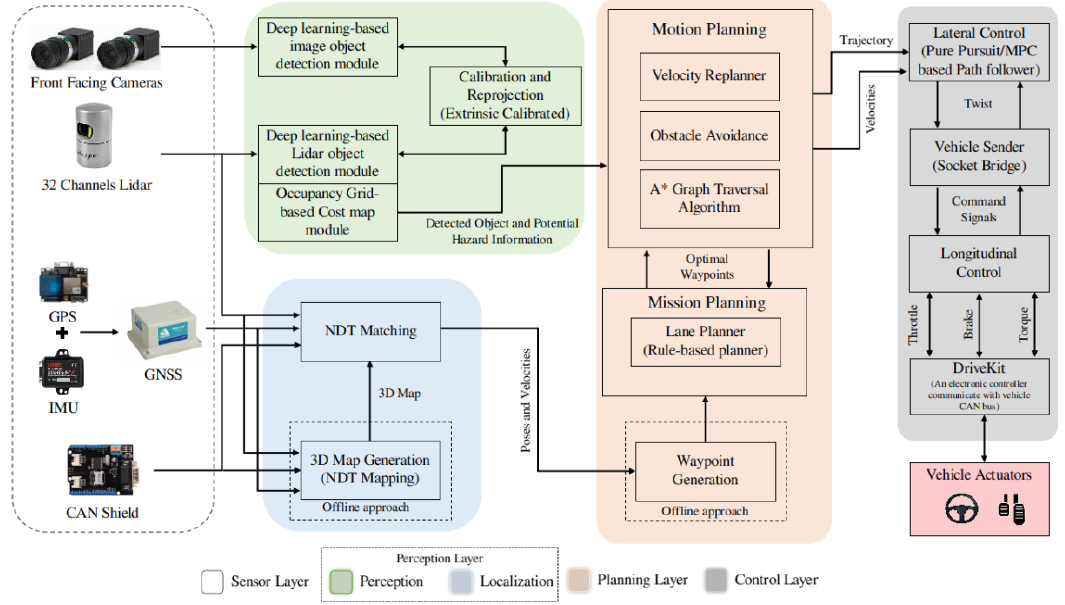
Figure 4. Overall architecture of our autonomous vehicle system. It includes sensors, perception, planning and control modules (Best viewed in